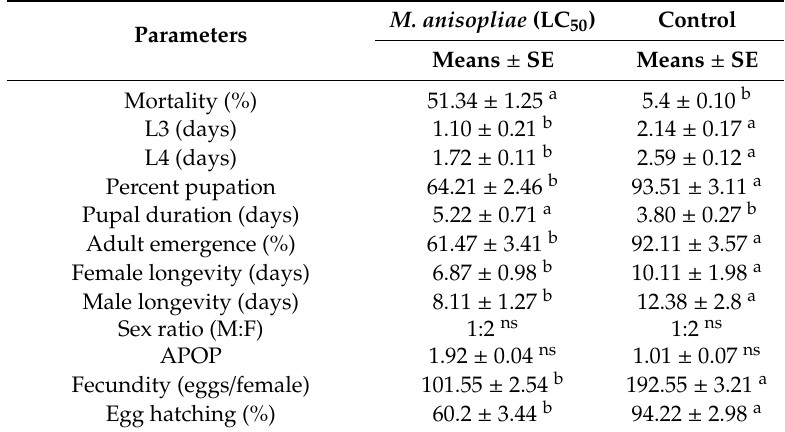
of female adult; means in the same row followed by the same letter are not significantly different ( p > 0.05).